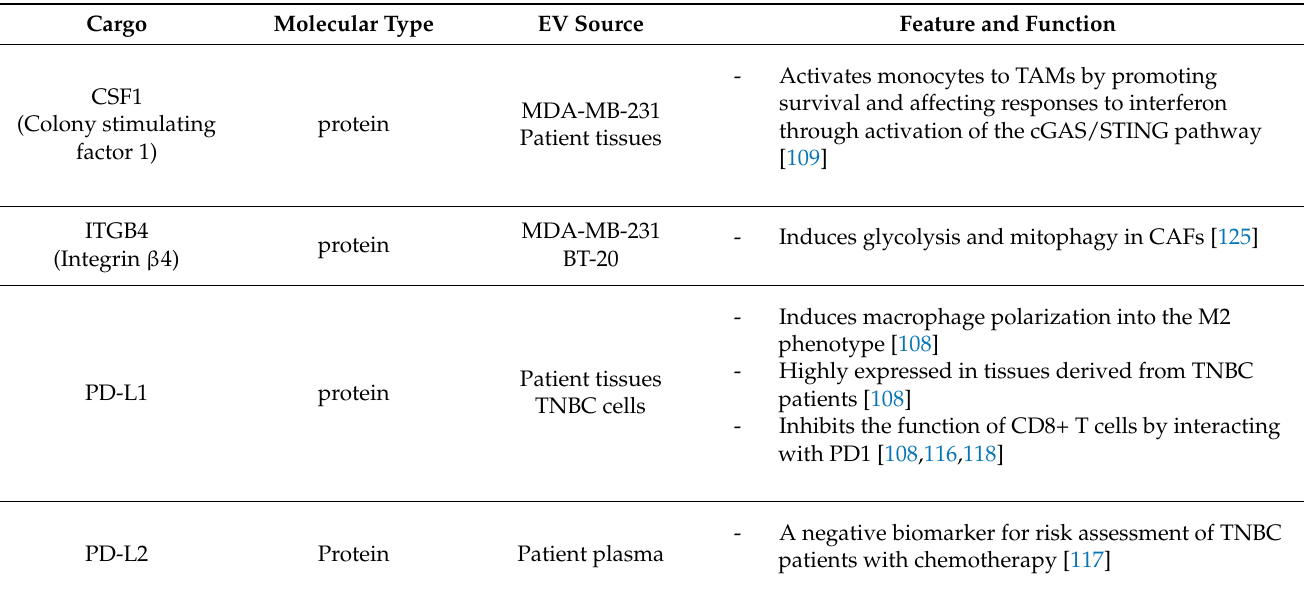
Table 2. TNBC-EV cargo components that modulate the TME and immune